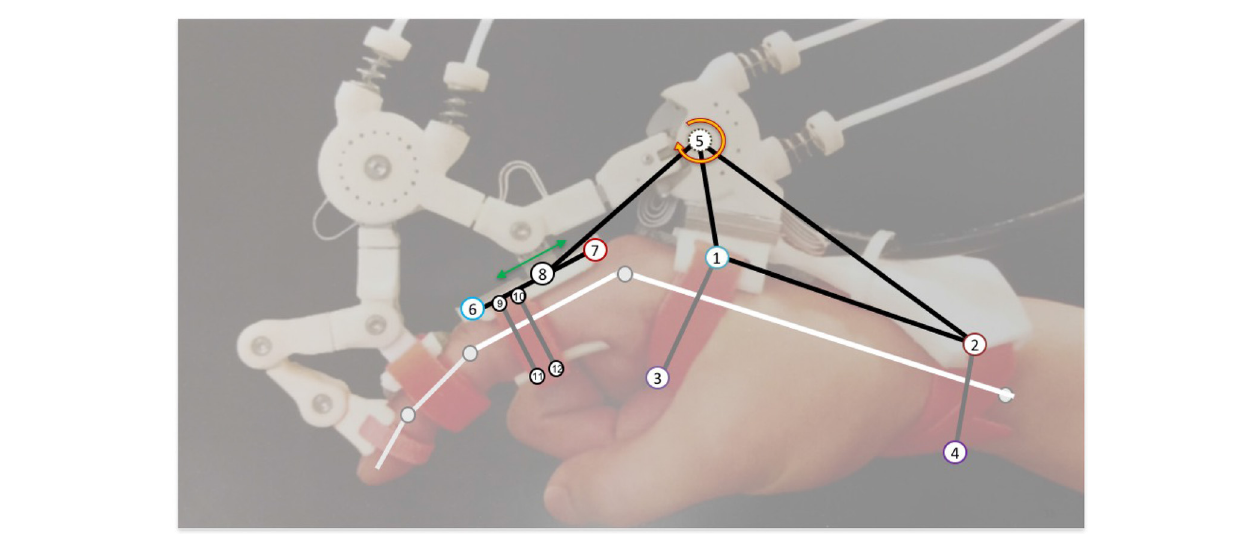
FIGURE 5 | Annotated Maestro system showing the symbolic human reference geometry (white), and the different pieces of the lumped parameter structure used to model and simulate the behavior of this system. Each numbered circle represents a PHRII (Though points 5 and 8 have their viscoelastic values set to zero as described in this section). The black lines represent inelastic constraints while the gray ones represent viscoelastic ones.